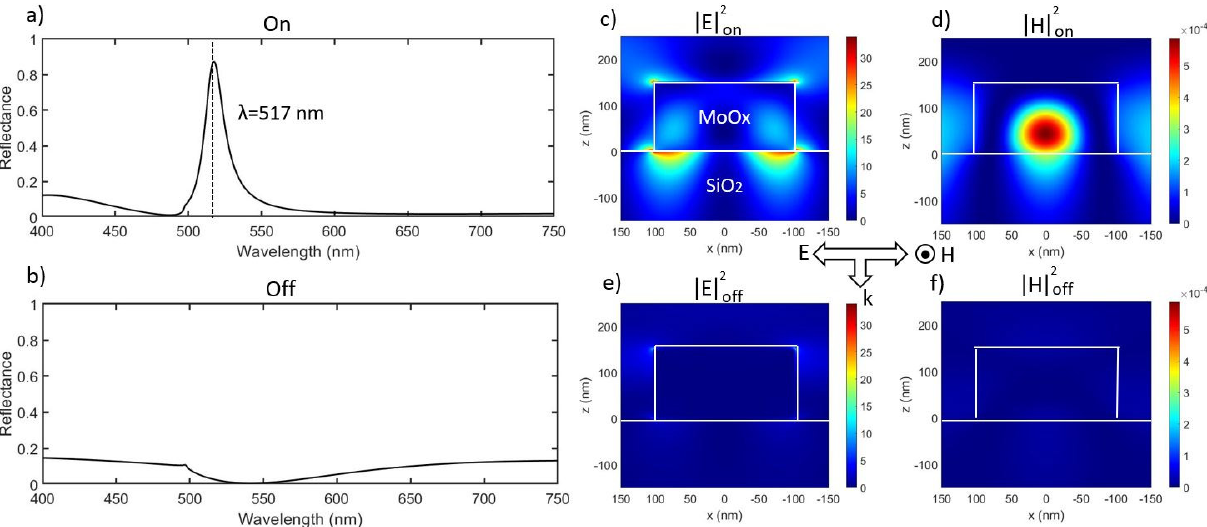
Figure 2. Reflectance of the proposed subpixel for the grating parameters d = 150 nm, P = 340 nm, and D = 0.6 for the ( a ) on and ( b ) off states, respectively. For the transparent version of the MoO x ribs, the reflection of the grating peaks occurs at λ = 517 nm. Square module of the electric field in near-field regime when the incident wavelength is λ = 517 nm (spectral position of the reflectance maximum) for the ( c ) on and ( e ) off states, respectively. Square modulus of the magnetic field in the near-field regime when the incident wavelength is λ = 517 nm for the ( d ) on and ( f ) off states, respectively. The electric field is orthogonal to the grating ribs and the magnetic field is parallel.